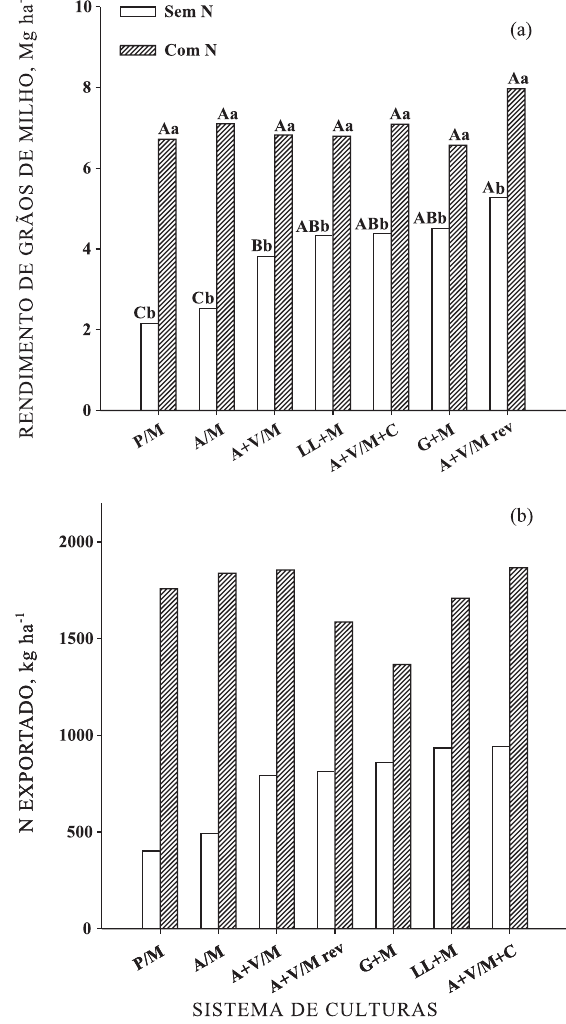
Figura 2. Estoques de N total na camada 0–20 cm do campo nativo (CN), no início do experimento (1983) e dos sistemas de culturas sob plantio direto com duas doses de nitrogênio mineral em 2005. Letras maiúsculas comparam sistemas de culturas (média das duas doses de N) e letras minúsculas comparam doses de N dentro de cada sistema de cultura, por meio do teste de Tukey